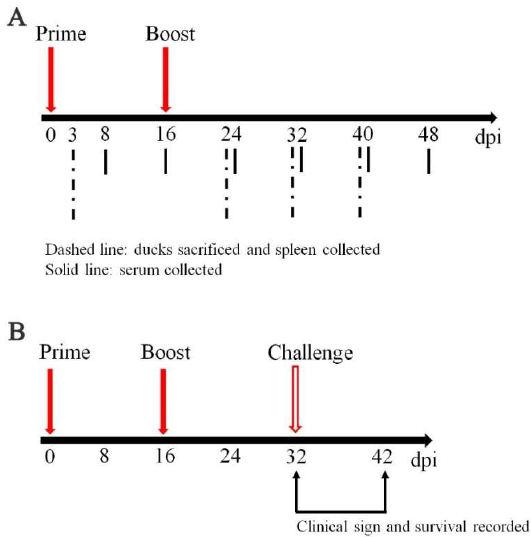
Figure 1. ( A ) Schedule of vaccination and sample collection. Ducks were orally vaccinated with 10 10 CFU of SL7207 (pVAX-C) and SL7207 (pVAX) at 8-day-old and 24-day-old, respectively. Animals were sacrificed at 3, 24, 32 and 40 dpi to collect the spleen ( n = 3 of each time point). Sera were collected at 8, 16, 24, 32, 40 and 48 dpi ( n = 3 of each time point); ( B ) Schedule of challenge experiment. 10 ducks of each group were randomly selected at 32 dpi for the immune protection test and mortality was recorded for continuous 10 days after exposure of duck tembusu virus